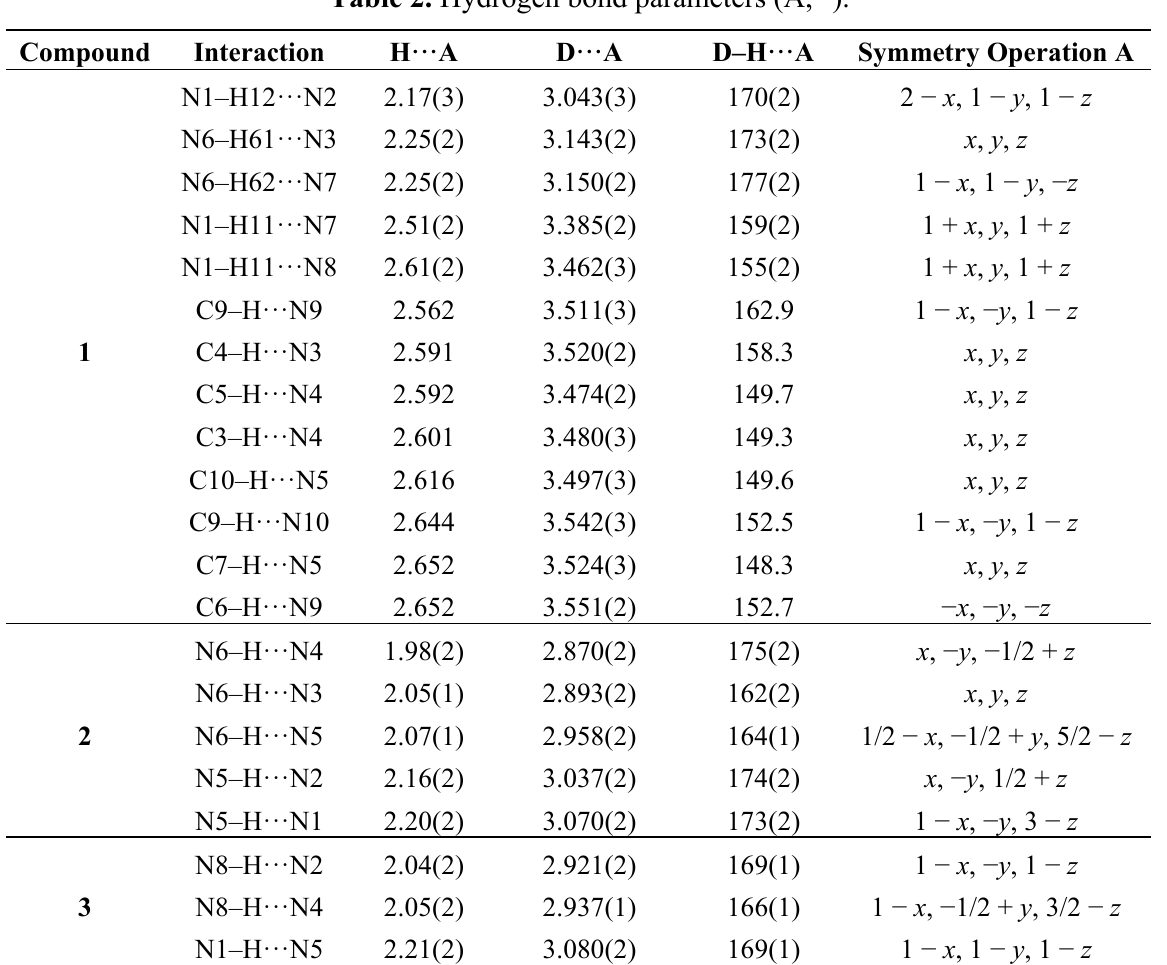
Table 2. Hydrogen bond parameters (Å,